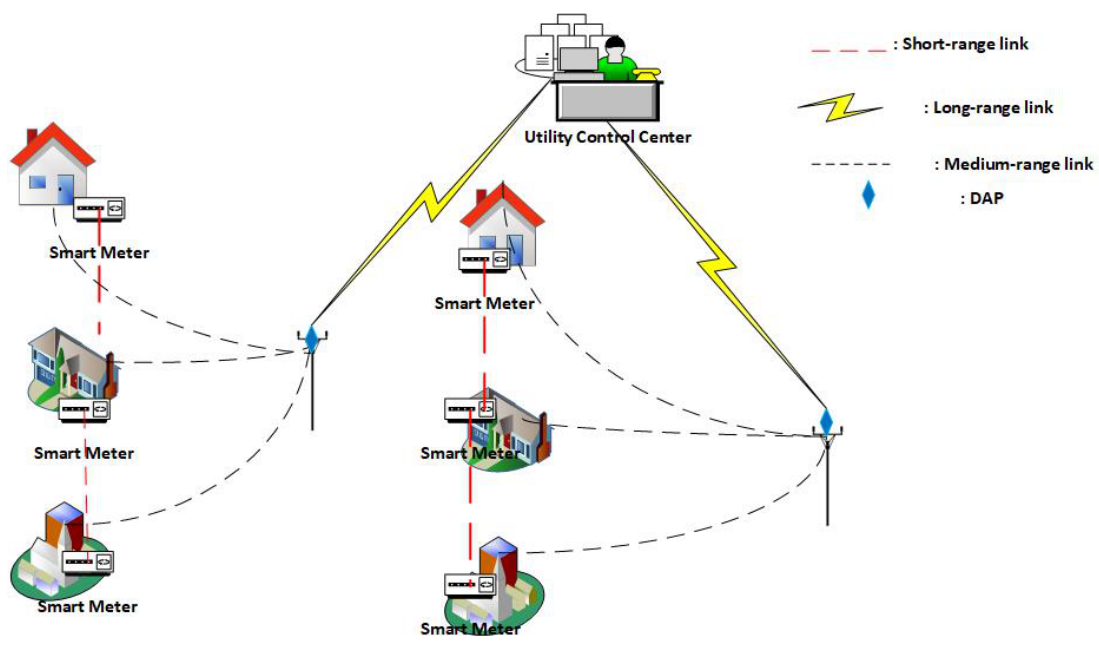
Figure 3. A typical two-way communication